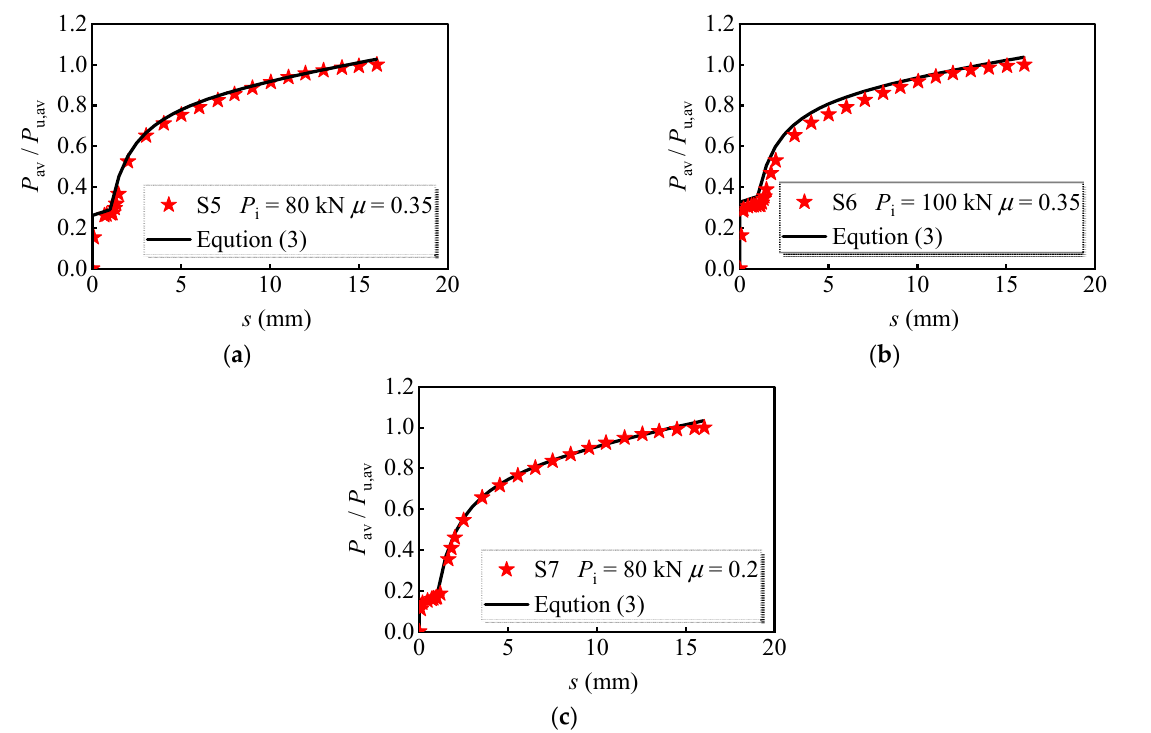
Figure 21. The regression curve without considering preload and interface friction.